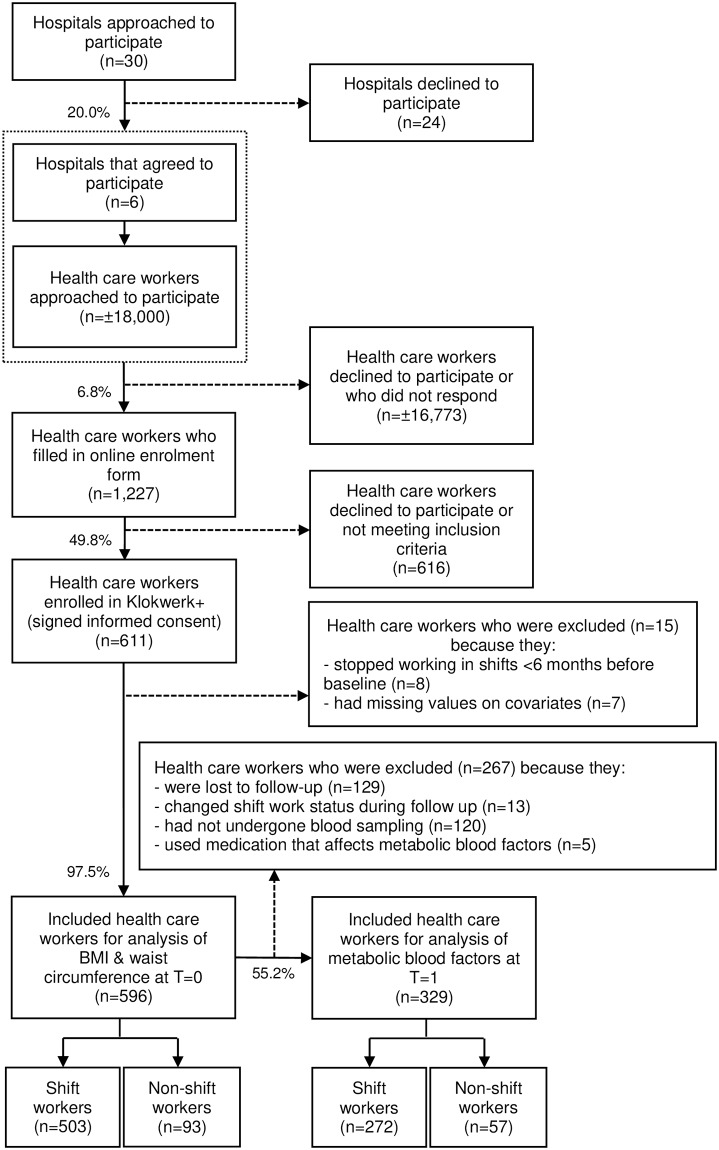
Flowchart of study participants.